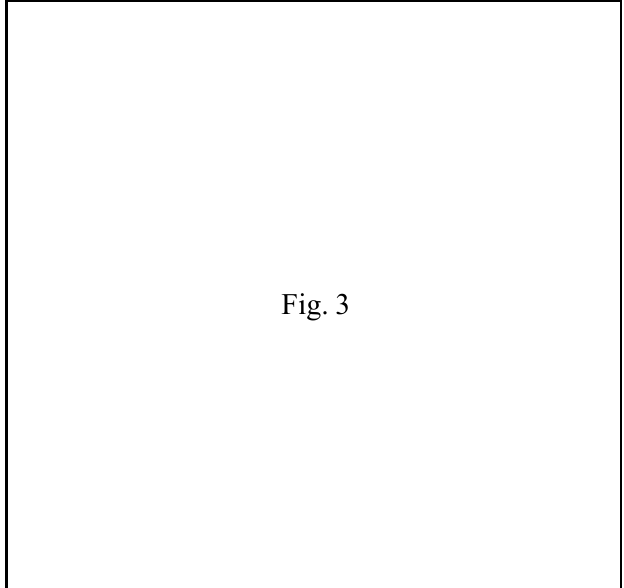
Fig. 3 : CT scan of the cervical spine with sagittal reconstruction, showing burst fracture of fifth cervical